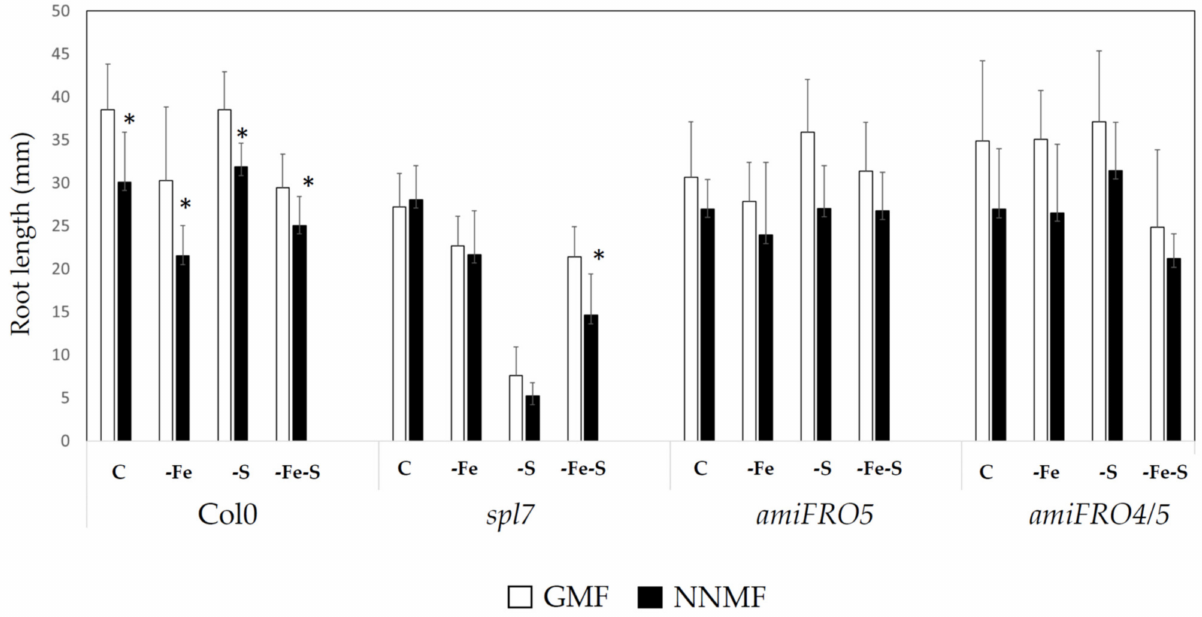
Figure 5. Root length of Arabidopsis thaliana lines (Col0, spl7 , amiFRO5 , amiFRO4/5 ) grown under full nutrient conditions (C), absence of iron (-Fe), absence of sulfur (-S), and combined Fe and S deficiency (-Fe-S). Root lengths were measured 7 days after transferring seedlings to NNMF conditions. Mean values ( ± SE) are from 3 independent biological experiments; asterisks indicate statistical difference ( p < 0.05) between NNMF and GMF exposed